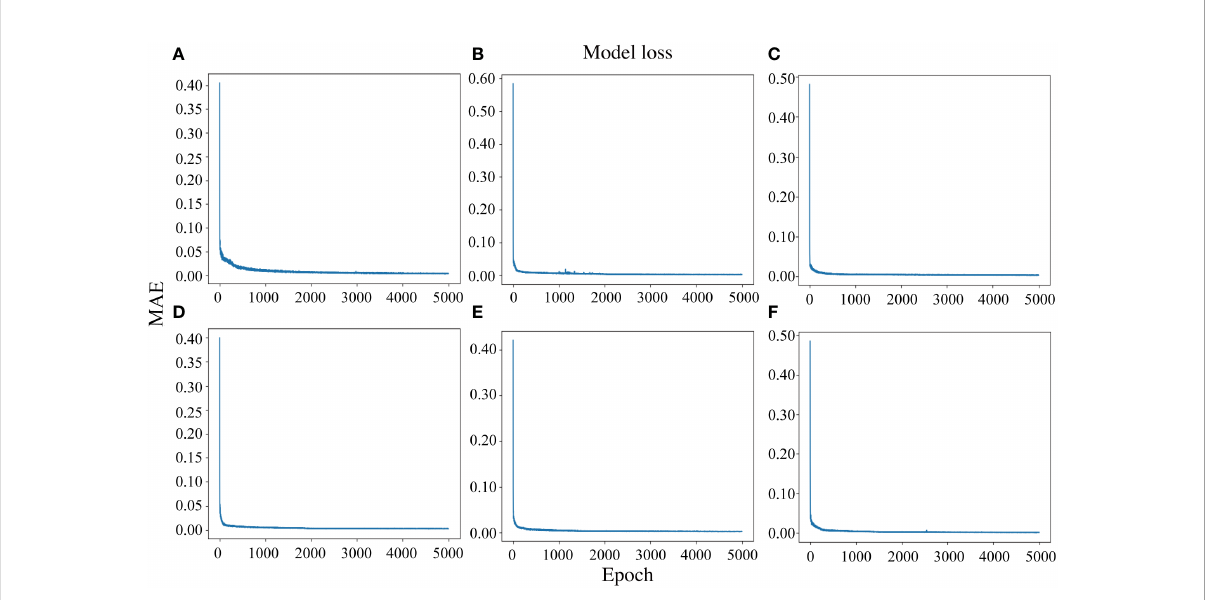
FIGURE 7 The loss rate curve of the 1D-CNN model with different drought conditions and cotton growth stages. (A – C) , Flowering stage, boll setting stage, and boll opening stage under normal conditions, respectively; (D – F) , Flowering stage, boll setting stage, and boll opening stage under drought stress,